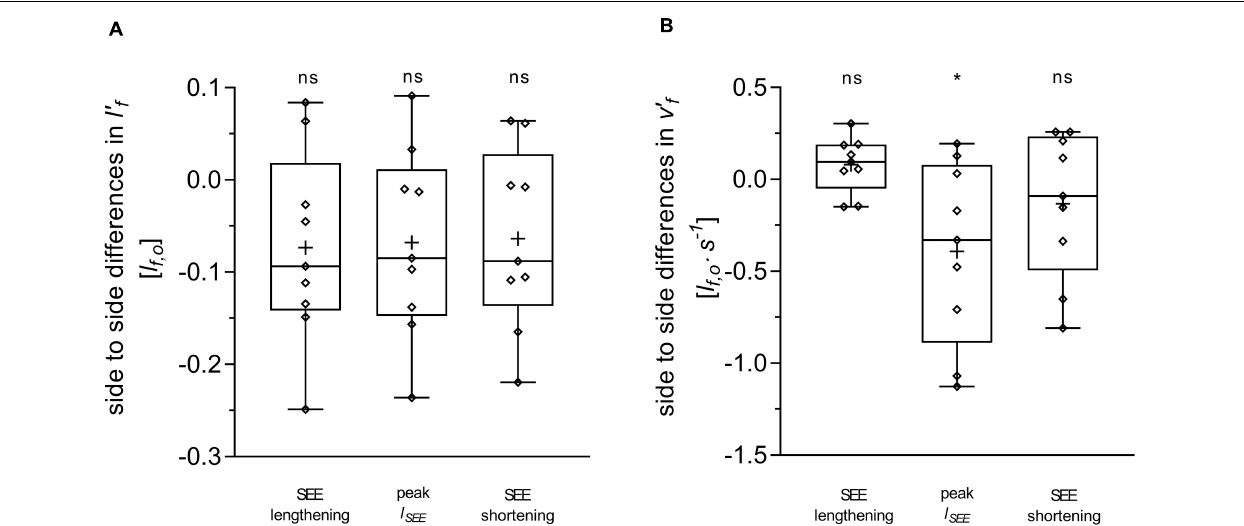
FIGURE 4 | Differences between the affected and unaffected legs in gastrocnemius medialis normalized fascicle length ( l (cid:48) f ) (A) and normalized fascicle velocity ( v (cid:48) f ) (B) . Statistical testing was run on average values during the series elastic element (SEE) lengthening and shortening sub-phases, and on single data points at peak SEE length ( l SEE ). The lower and upper parts of the box plots represent the first and third quartile, respectively. The length of the whisker delineates the minimum and maximum values. The horizontal line in the box represents the median of the sample; +, sample mean; * p < 0.05, significant side-to-side difference; ns: non-significant.